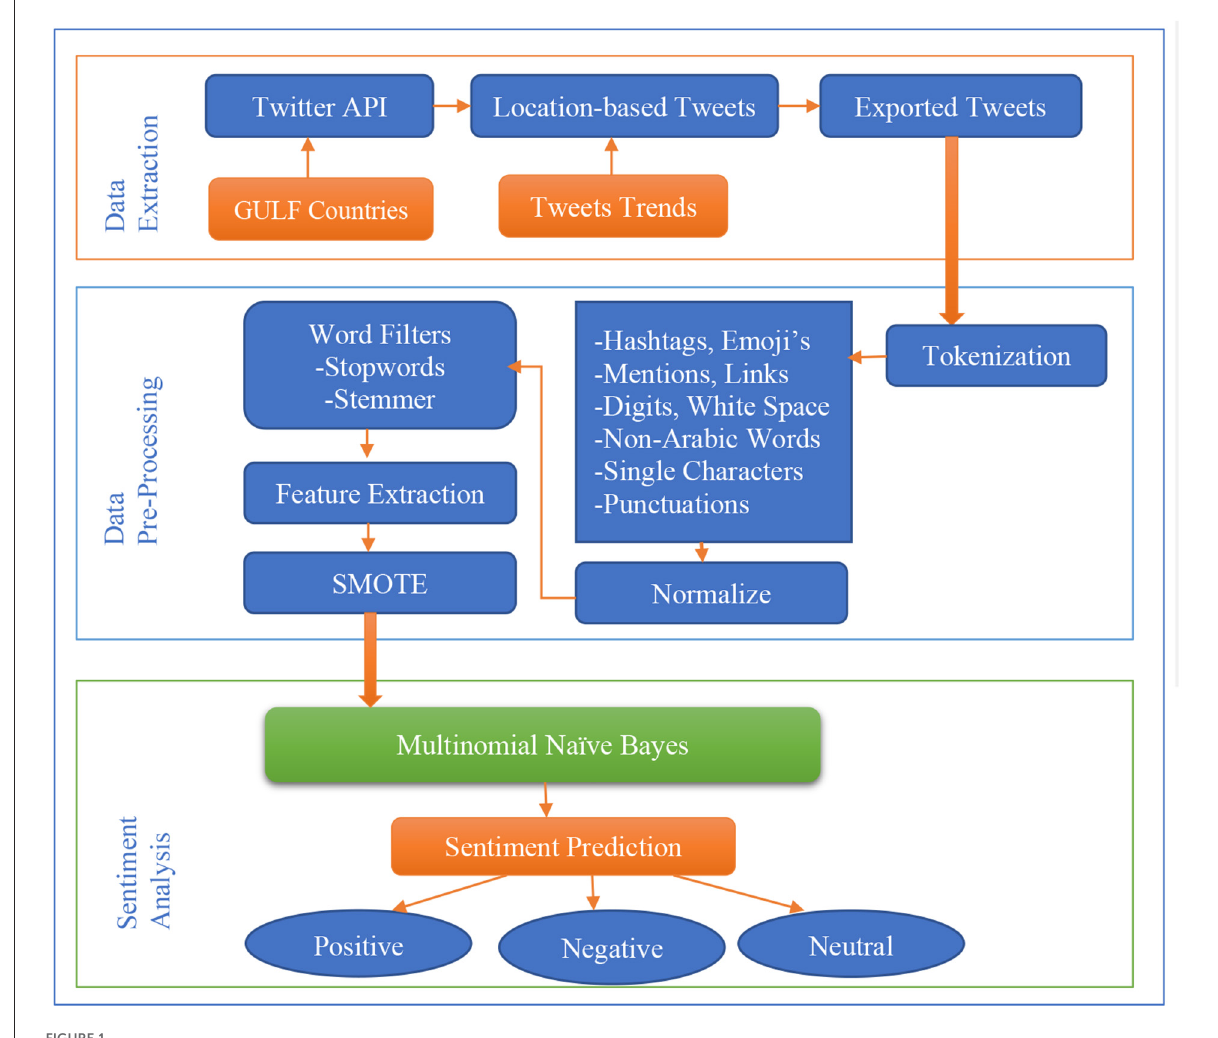
FIGURE1 The proposed sentiment analysis